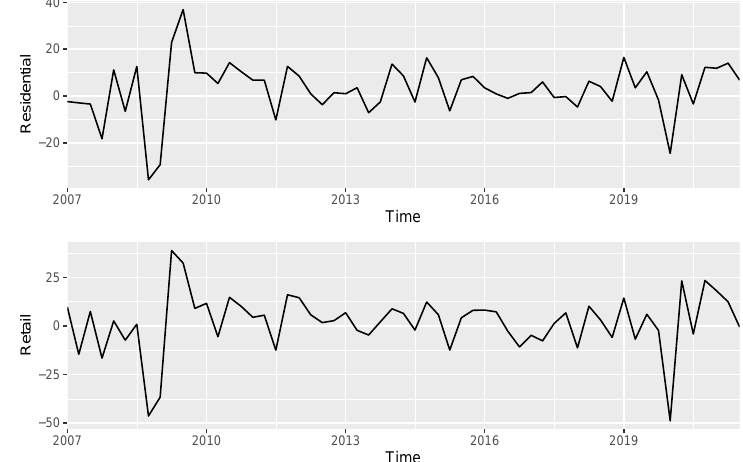
Figure A1. Total Return Series of REITs Indices.